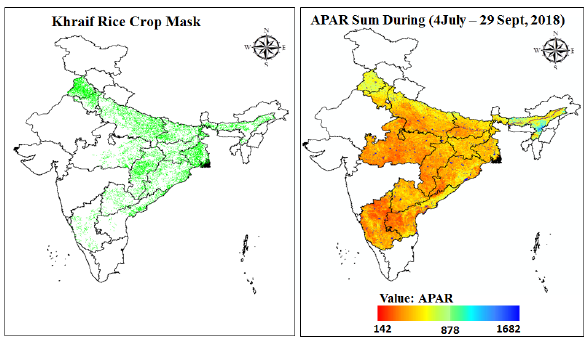
Figure 8: Kharif Rice Crop Mask & Sum of APAR (4 July - 29 Sept, 2018)